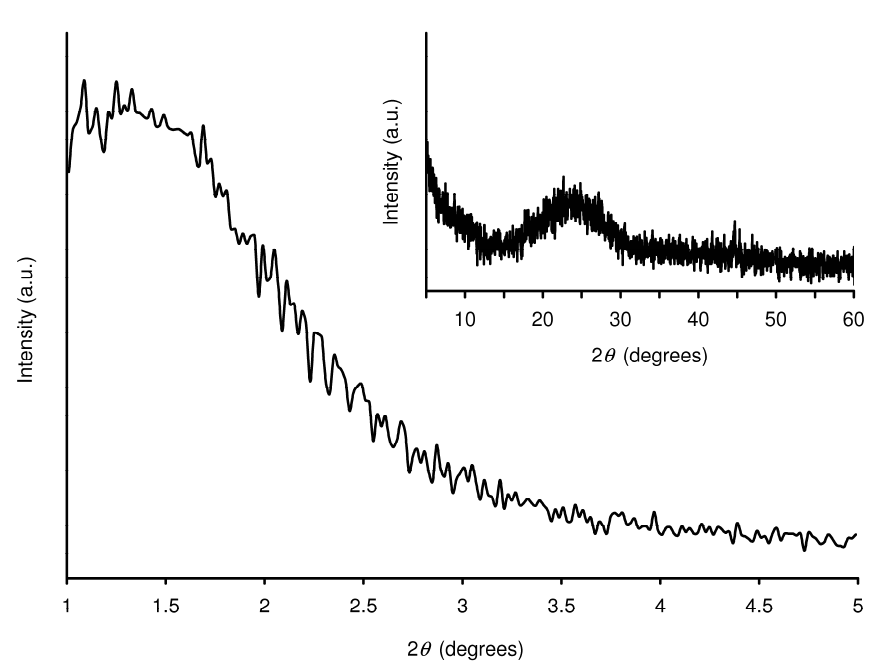
Figure 1. Powder XRD pattern of Al-TUD-1.